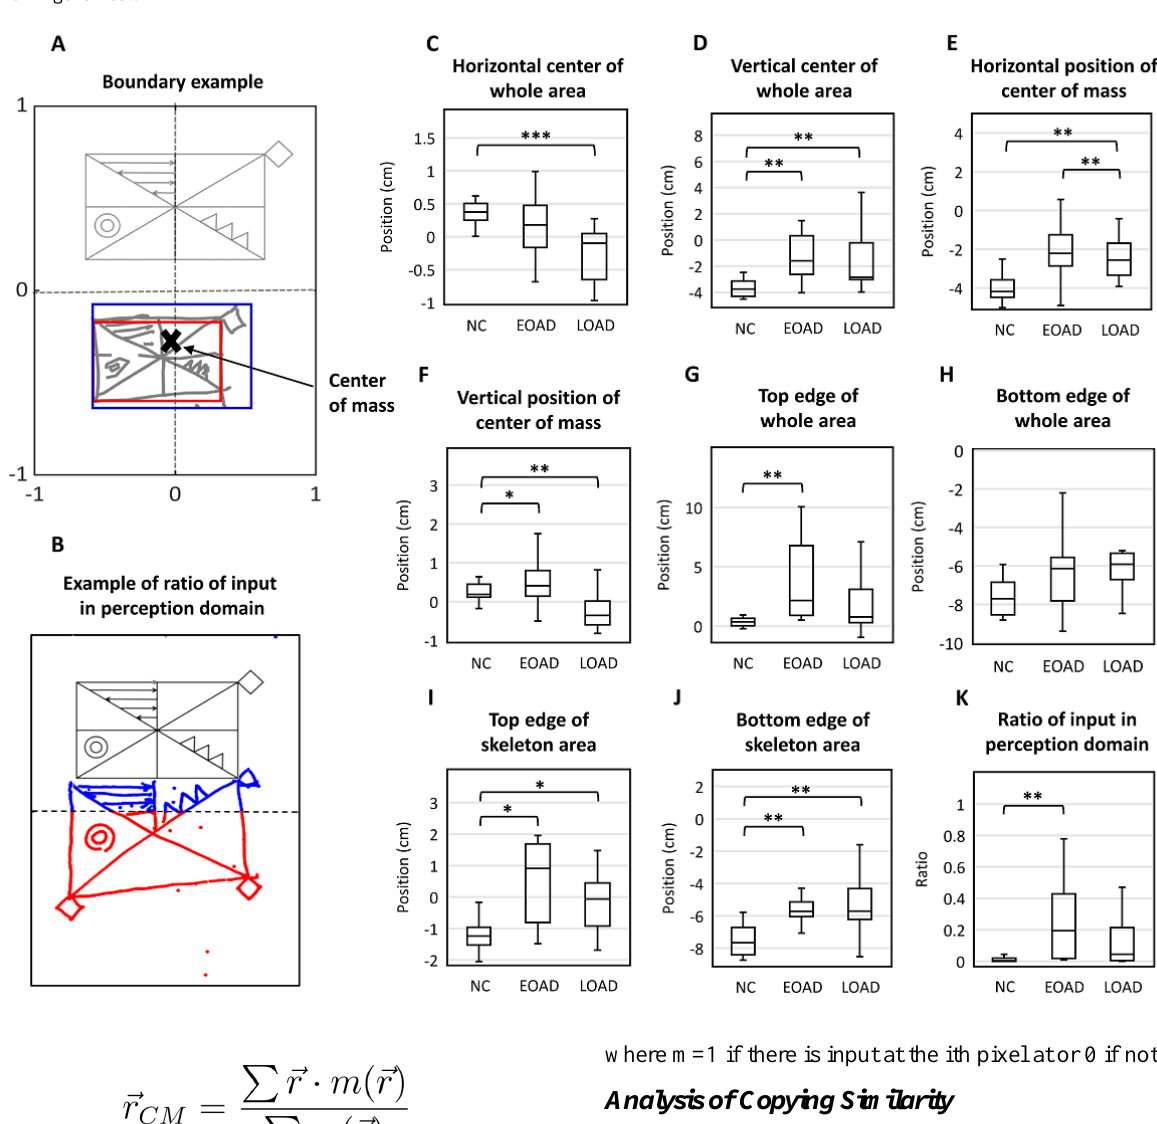
Figure 3. Spatial arrangement. (A) We defined the bounded area that contains the whole drawing as the whole area (blue box) and a boundary that contains only the area inside the skeleton rectangle as the skeleton area (red box). (B) An example of the ratio of input in perceptual space: input (blue)/total input (blue + red). (C-D) Center of the whole area. (E-F) Center of mass of the whole area. (G-H) Top and bottom edge of the whole area. (I-J) Top and bottom edges of the skeletal area. (K) Closing-in phenomenon. One, two, and three asterisks show significant differences at P <.05, P <.01, and P <.001 levels, respectively. EOAD: early-onset Alzheimer disease; LOAD: late-onset Alzheimer disease; NC: normal control; RCFT: Rey-Osterrieth Complex Figure